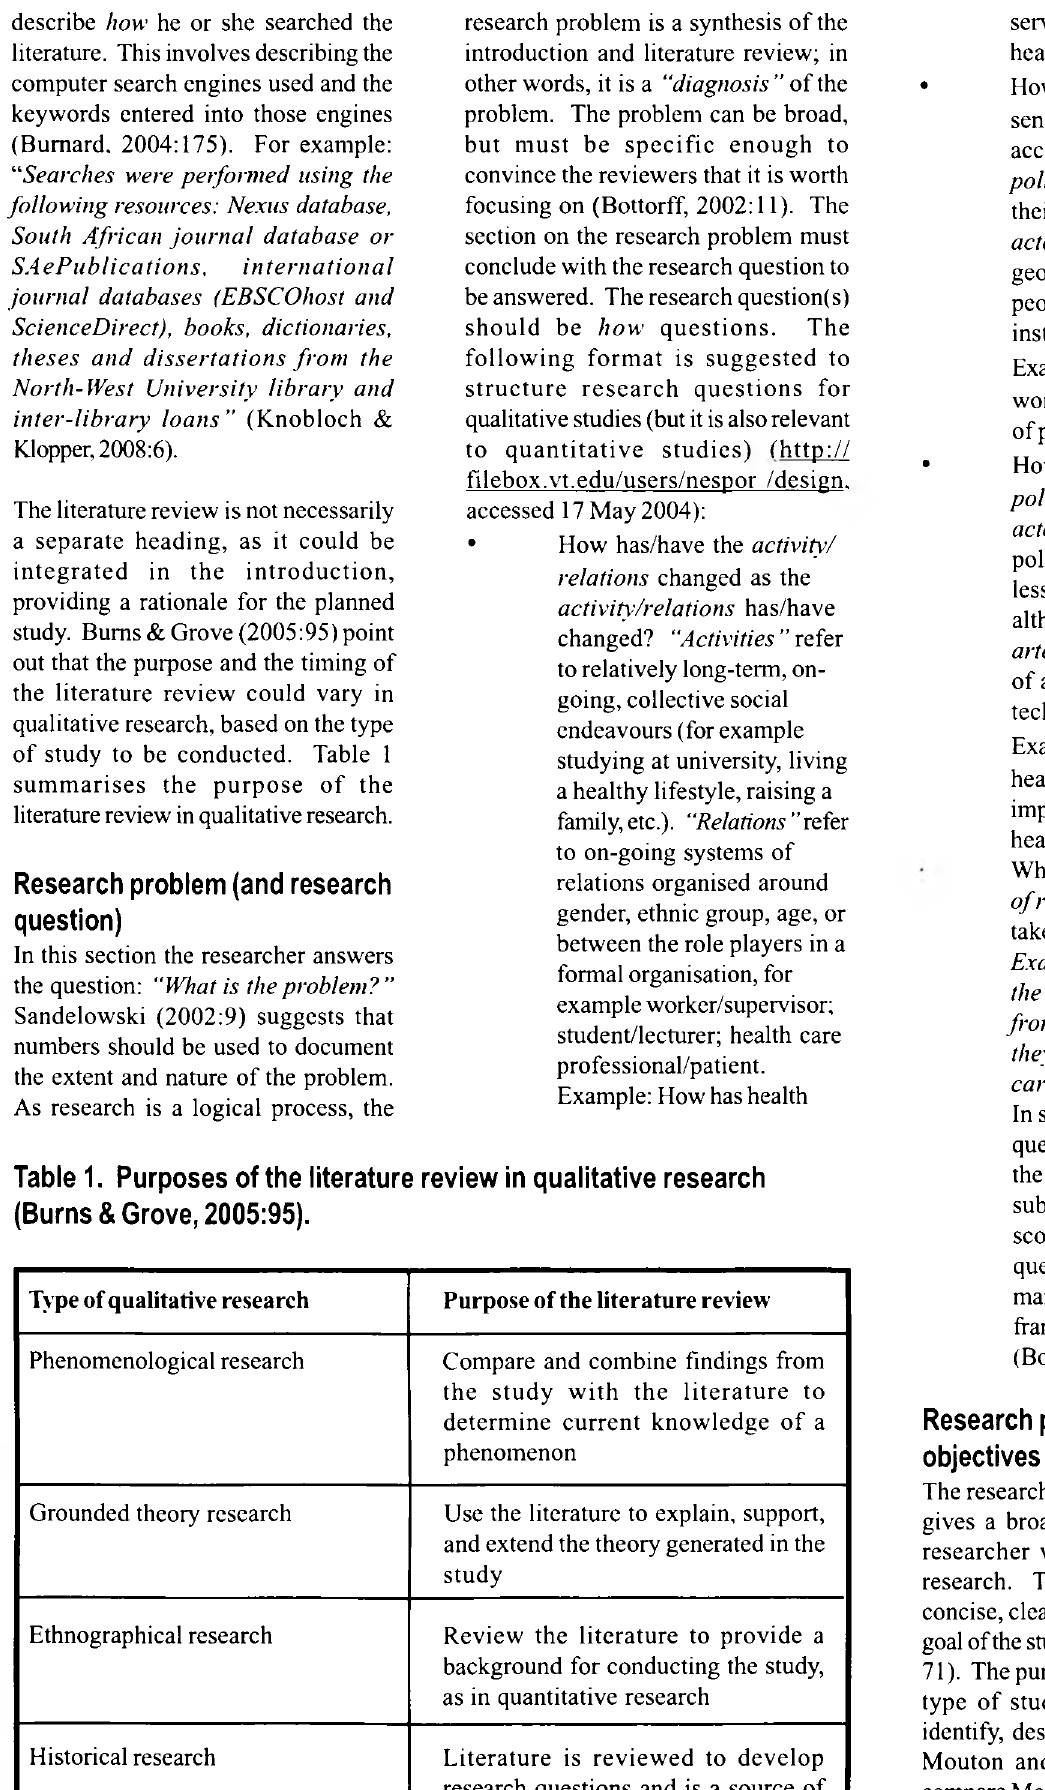
Table 1. Purposes of the literature review in qualitative